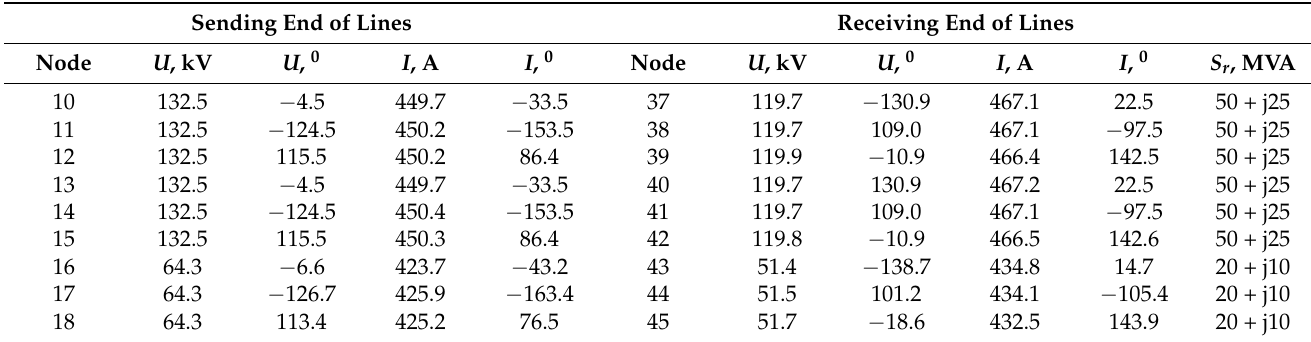
Table 3. Calculation results for the transmission line corridor power flow.